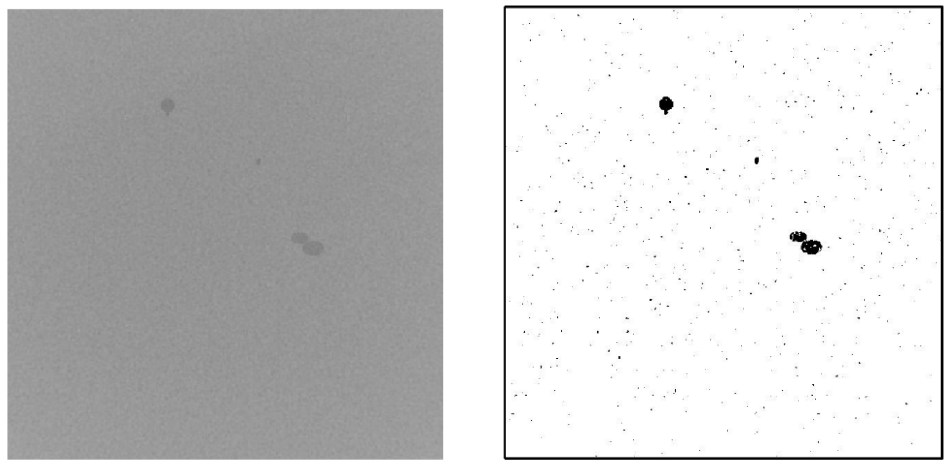
Figure 23. Final version of artificial image ( Left ) vs. binarized artificial image ( Right ). As can be seen in the figure, there are tiny undesired black spots in different positions in